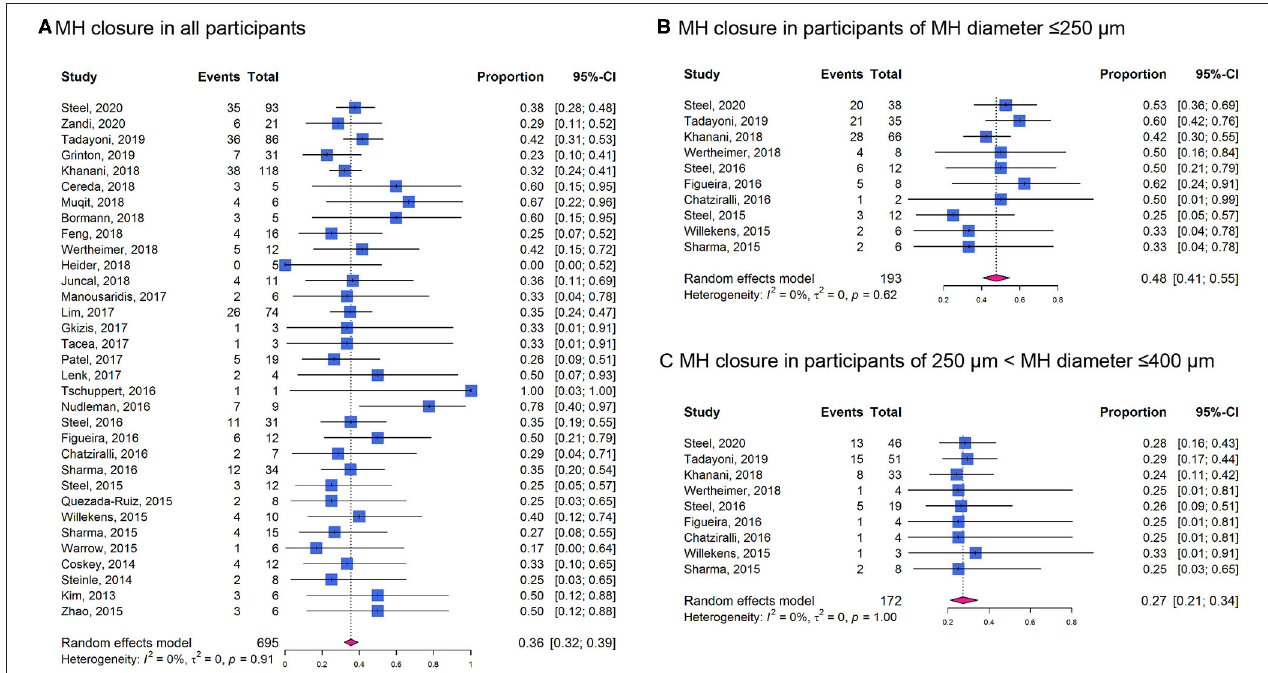
FIGURE 5 | Forest plots of proportion of MH closure in participants receiving ocriplasmin therapy in included cohort studies. (A) In all the participants; (B) In participants of MH diameter ≤ 250 µ m; (C) In participants of MH diameter of 250–400 µ m.